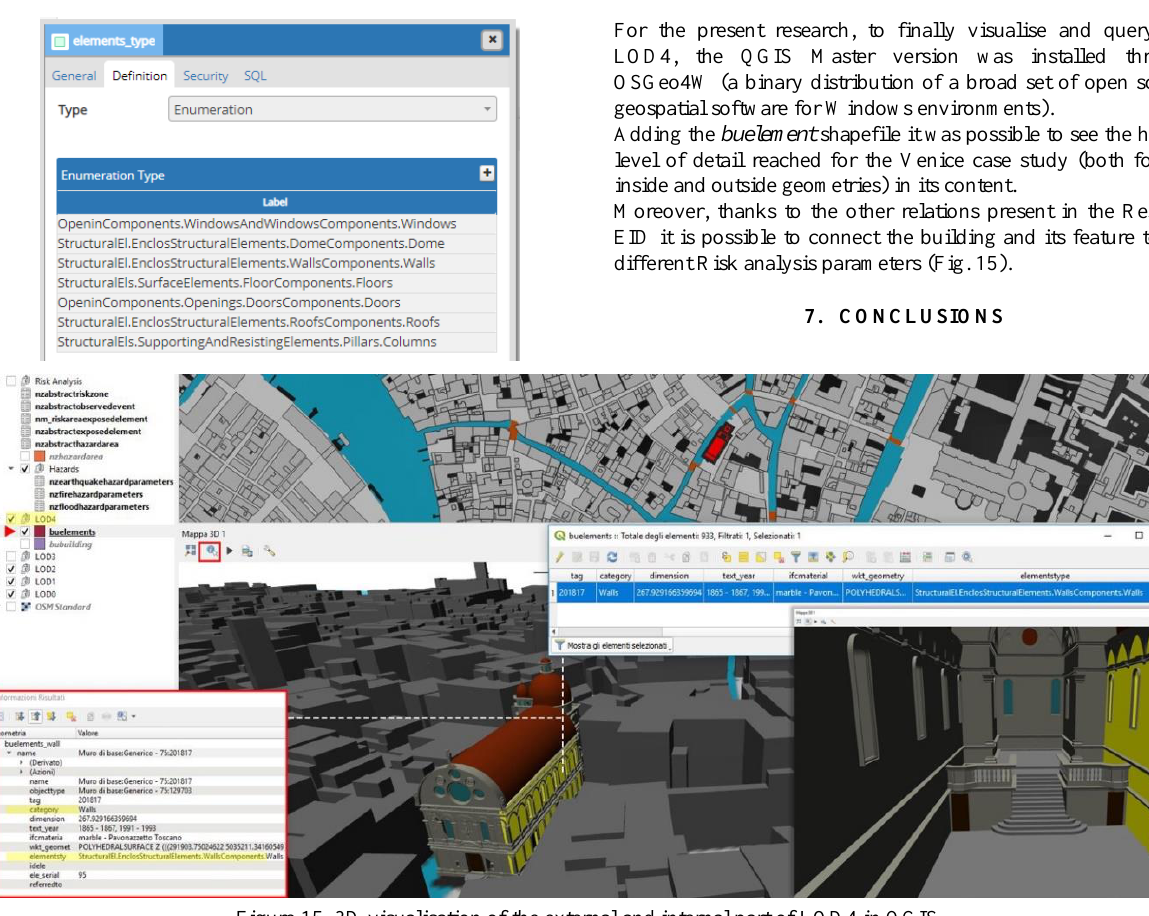
Figure 15. 3D visualisation of the external and internal part of LOD4 in Figure 14. Rescult.elements type code-list from the Getty ATT vocabulary.